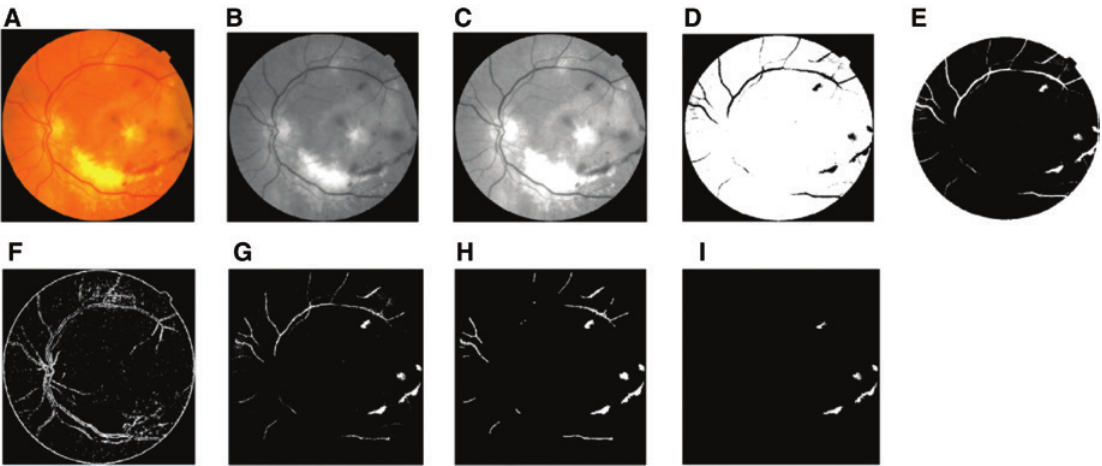
Figure 4: Segmentation Process for Affected Hemorrhage